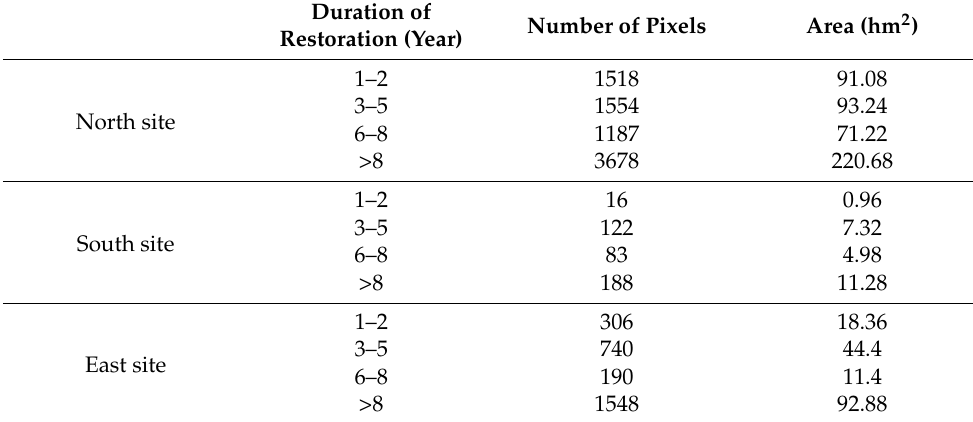
Table 4. Duration of